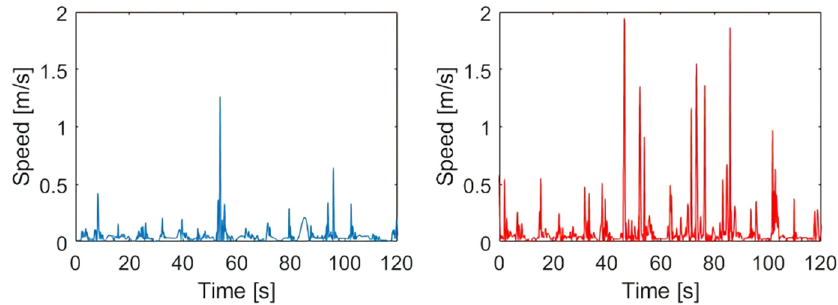
Figure 6. Example of a Healthy (blue) and SCI (red) participant speed profile of x axis measured from the end-effector of Novint Falcon device in the Picking bananas game.